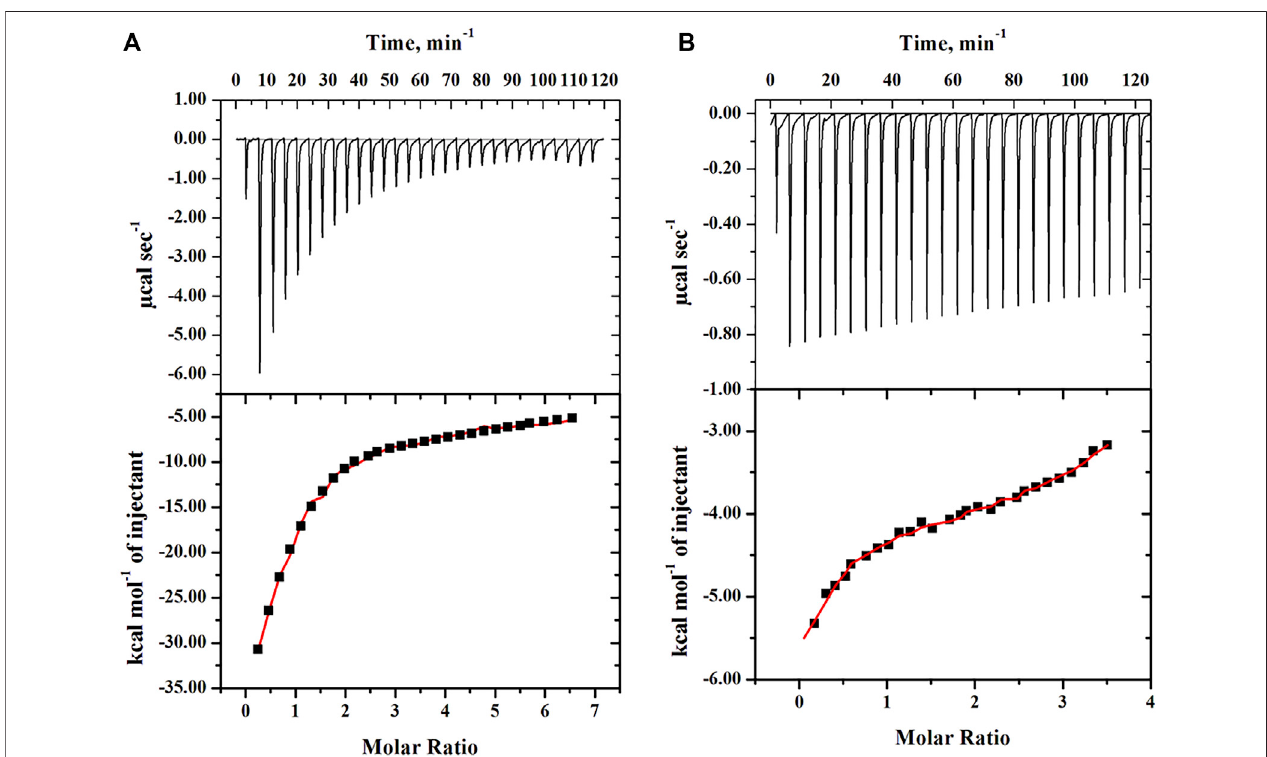
FIGURE 5 | Calorimetric binding measurements of cyt c titrated by (A) PEG 10 and (B) PEG 20 at 25 ° C. The upper panel shows the observed heat after each injection.Foreach fi gure,thelowerpanelrepresentstheintegrationofthedatashownintheupperpanelplottedasafunctionofthemolarratiooftheproteintothePEG.